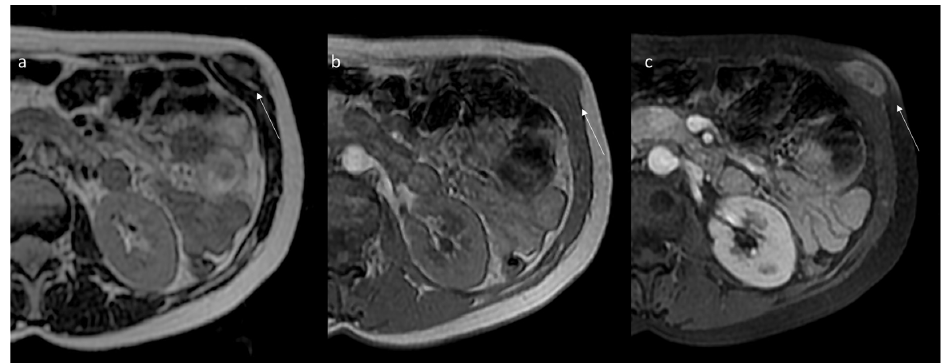
Figure 6. Desmoid of the anterior abdominal wall. MRI axial slices in T2 ( a ), T1 ( b ), and gadolinium- enhanced T1 ( c ) sequences. A nodular lesion is evident within the muscular and fascial planes of the internal and external oblique muscles (arrow) .